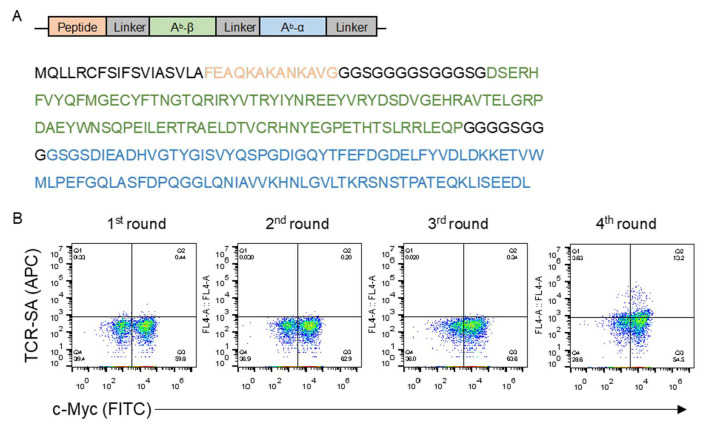
Evolution of peptide-Ab yeast display.(A) Cartoon representation and protein sequence used for the peptide-Ab yeast display. (B) TCR tetramer staining of the naïve library and the four consecutive rounds of yeast selection using the YAe TCR. The peptide-Ab library was generated following the random mutagenesis by error-prone PCR of the construct shown in (A). (C) Size exclusion chromatography of the vTreg53 TCR following purification by Ni-NTA column and overnight biotinylation using BirA enzyme. (D) Reducing and non-reducing SDS-PAGE of the vTreg53 TCR fractions collected in (C).